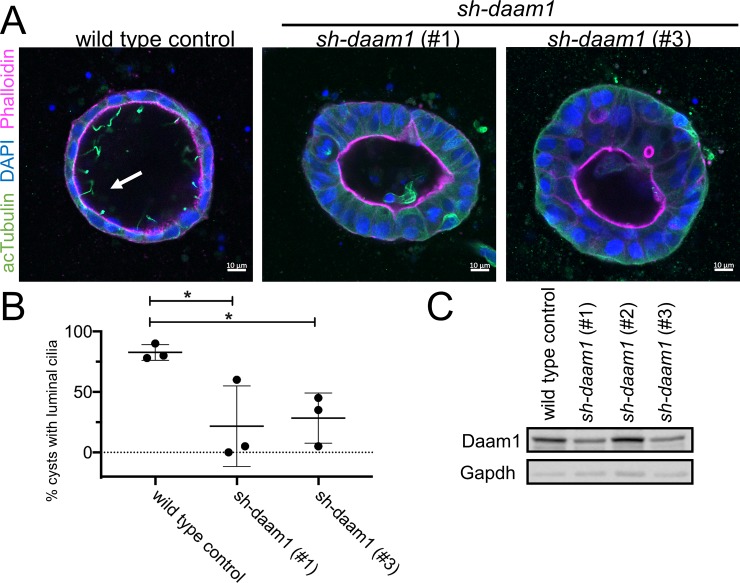
sh-daam1 depleted MDCKII cells show reduced luminal ciliogenesis in 3D cultures.Control and sh-daam1-depleted cells were cultured in collagen I matrix to form cysts. After 12–14 days in culture, cysts were fixed and stained with an antibody against acetylated α-Tubulin (acTubulin) to visualize primary cilia (green), phalloidin for F-actin (magenta) and DAPI for nuclei (blue). Using confocal imaging we analyzed the effect of Daam1 depletion on ciliogenesis. A) Representative merged confocal images showing reduction of luminal cilia upon Daam1 knockdown. White arrow points to luminal cilia in control cysts. Scale bars equal to 10 μm. B) The graph shows quantification of cysts with luminal cilia for each condition. Twenty randomly chosen cyst per sample were analyzed in three independent experiments. Error bars are shown as ± SD; Significance was calculated using unpaired, two-tailed t-test; ns indicates p > 0.05, * indicates p < 0.05, **p < 0.01 C) Western blot showing Daam1 protein levels in wild-type (control) cells and in cells expressing different shRNAs targeting Daam1. GAPDH was used as loading control.